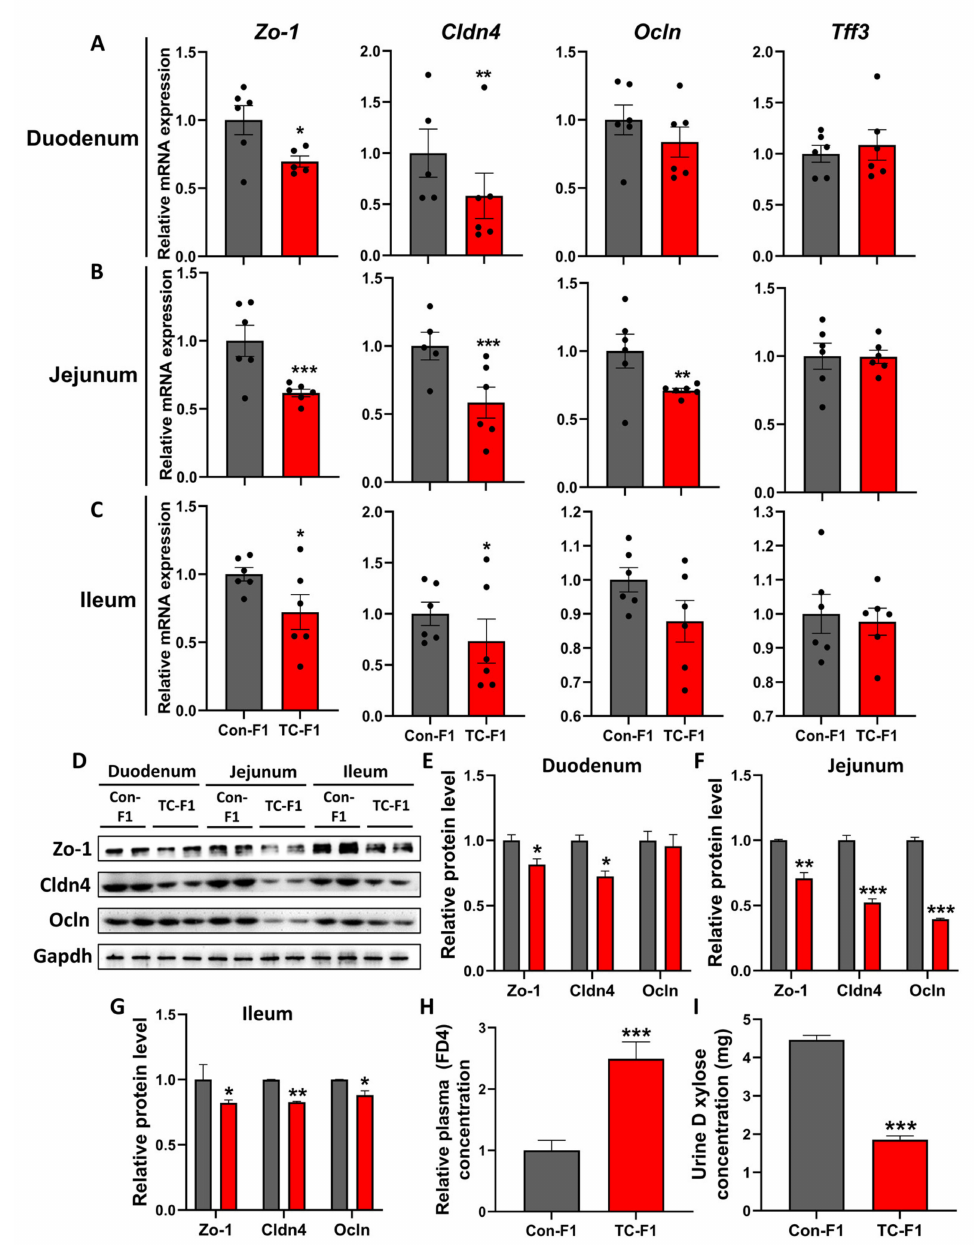
Figure 4. Early-life TC exposure compromises intestinal mucosal barrier integrity in female offspring. ( A – C ) Zo-1 , Cldn4 , Ocln and Tff3 mRNA expression in the duodenum ( A ), jejunum ( B ) and ileum ( C ) of 8-week-old offspring female mice, n = 5-6. ( D ) Zo-1, Cldn4 and Ocln protein levels in duodenum, jejunum and ileum of 8-week-old offspring female mice. ( E – G ) Quantitative statistics of Zo-1, Cldn4 and Ocln protein levels in the duodenum ( E ), jejunum ( F ) and ileum ( G ). ( H ) Relative concentration of plasma FITC (FD4), n = 10. ( I ) Urinary D-xylose concentration, n = 10. Data are expressed as mean ± SEM. * p < 0.05, ** p < 0.01, *** p < 0.001 vs.